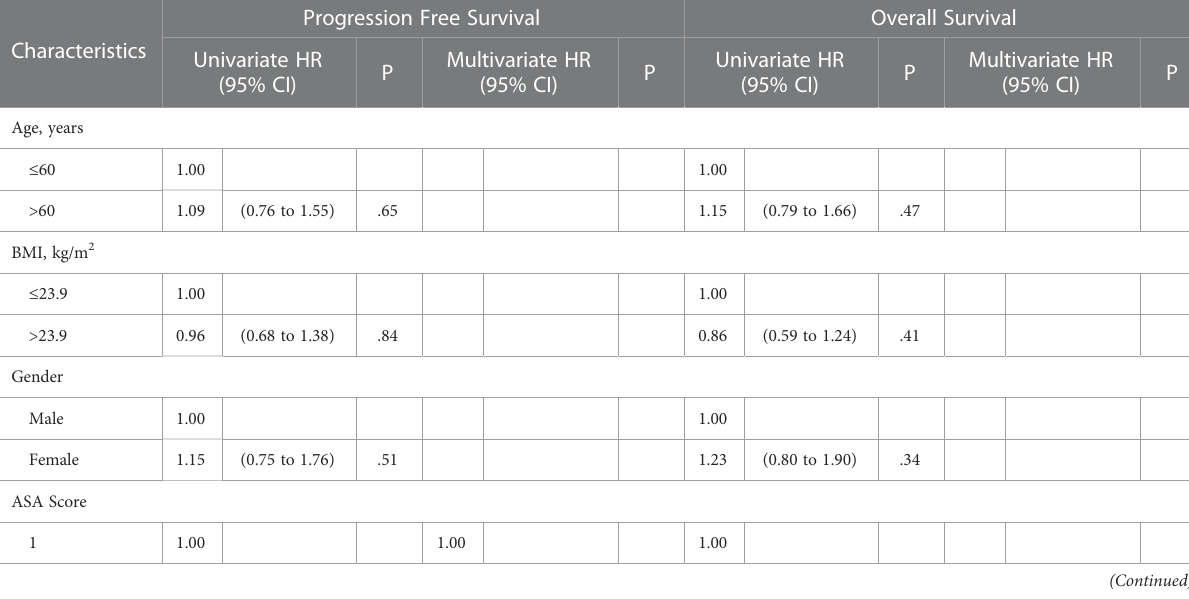
TABLE 2 Univariate and Multivariate Survival Analyses Using Cox Proportional Hazards Model.